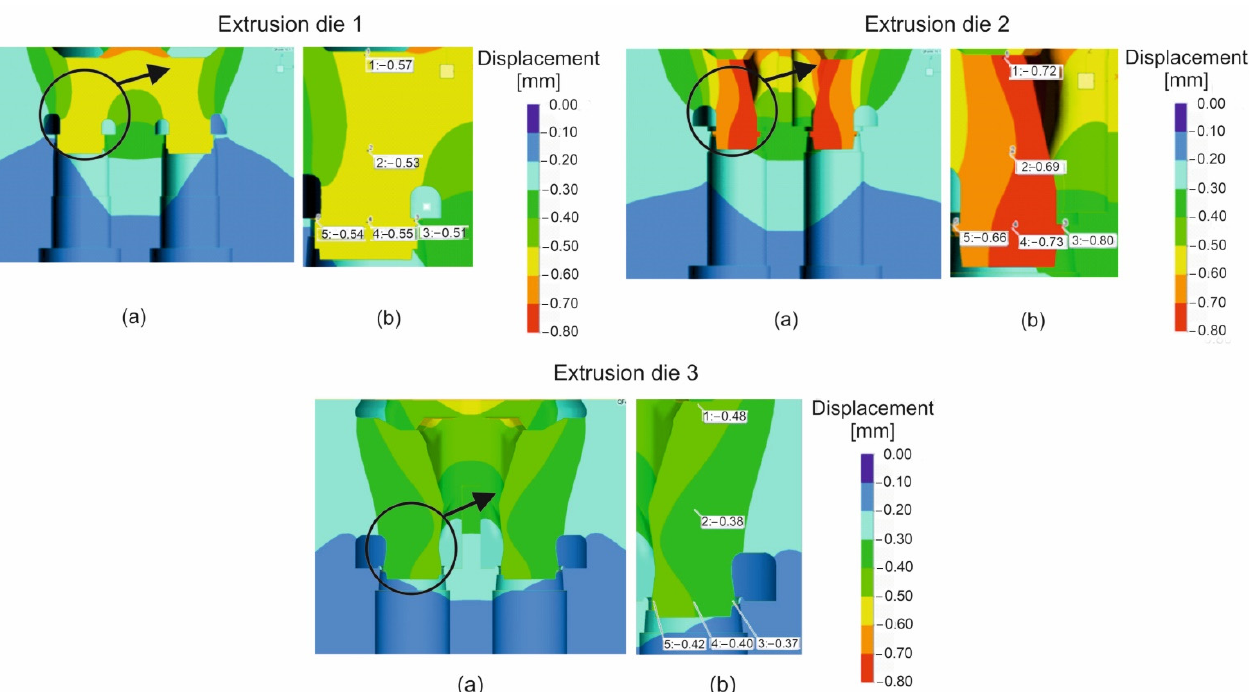
Figure 9. Distribution of die deflection during extrusion of tubes of Ø50 × 2 mm from 7021 aluminium alloy through porthole dies of different geometry—global view of mandrels ( a ) and local view of chosen part of mandrel ( b ).